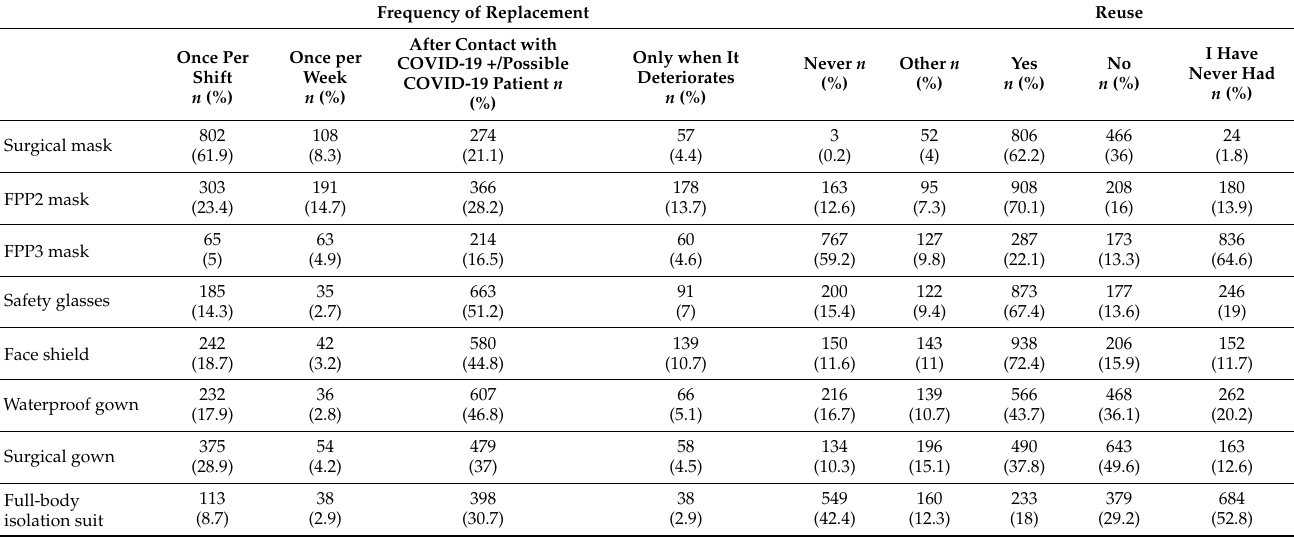
Table 3. Frequency of replacement and reuse of personal protective equipment ( n = 1296).